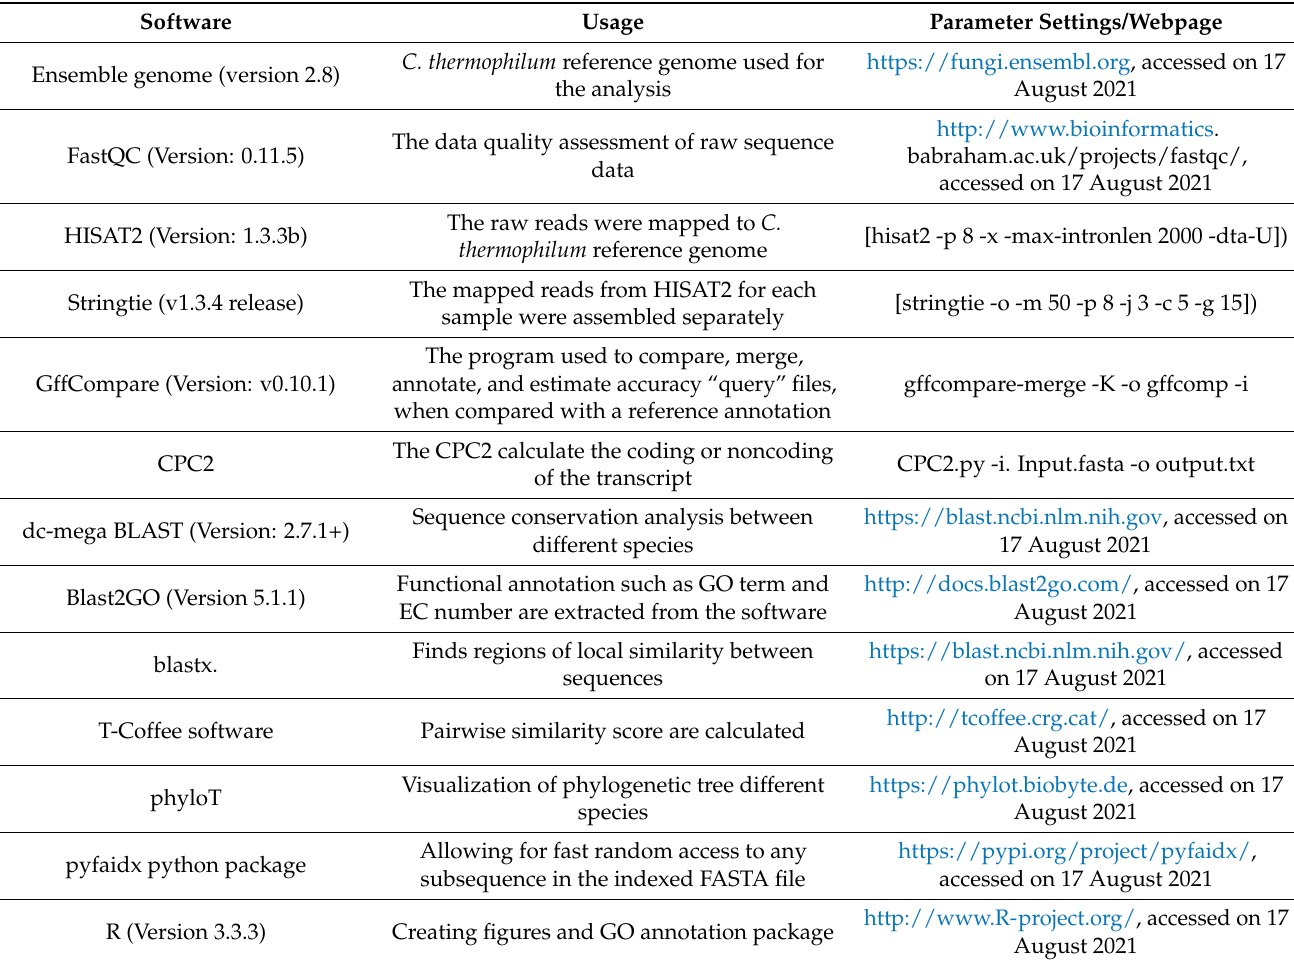
Table A2. RNA-seq data alignment results for three different